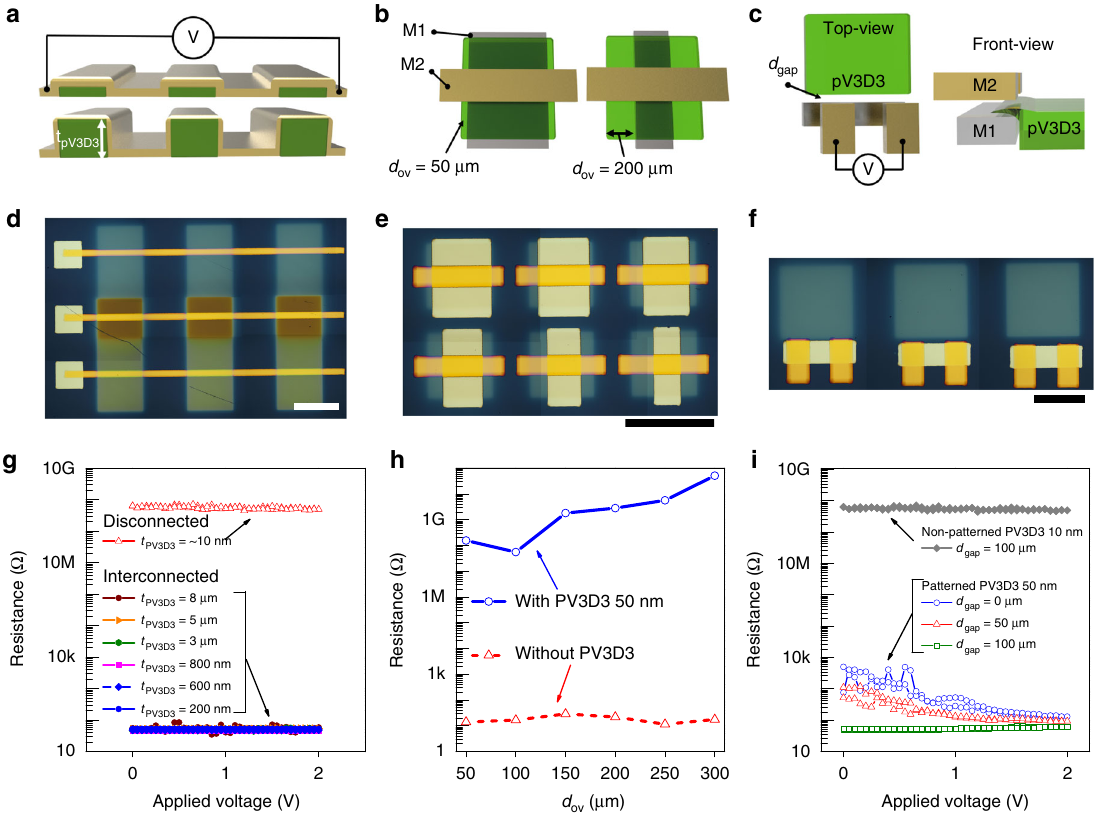
Fig. 2 Electrical evaluation of metal interconnect and isolation. a , d , g Electrical short test when the electrode is located on a patterned PV3D3 layer as a function of the PV3D3 layer thickness ( t PV3D3 ). Schematic ( a ), optical micrograph, scale bar, 1,000 µ m, ( d ), and resistance test results ( g ). b , e , h Electrical isolation test when the PV3D3 layer was sandwiched between two metal electrodes as a function of the length of the PV3D3 layer over the electrode ( d ov ). Schematic ( b ), optical micrograph, scale bar, 1000 µ m, ( e ), and resistance test results ( h ). c , f , i Electrical interconnect test when the patterned PV3D3 layer was located next to vertically stacked metal layers. Schematic ( c ), optical micrograph, scale bar, 1000 µ m, ( f ), and resistance test results ( i